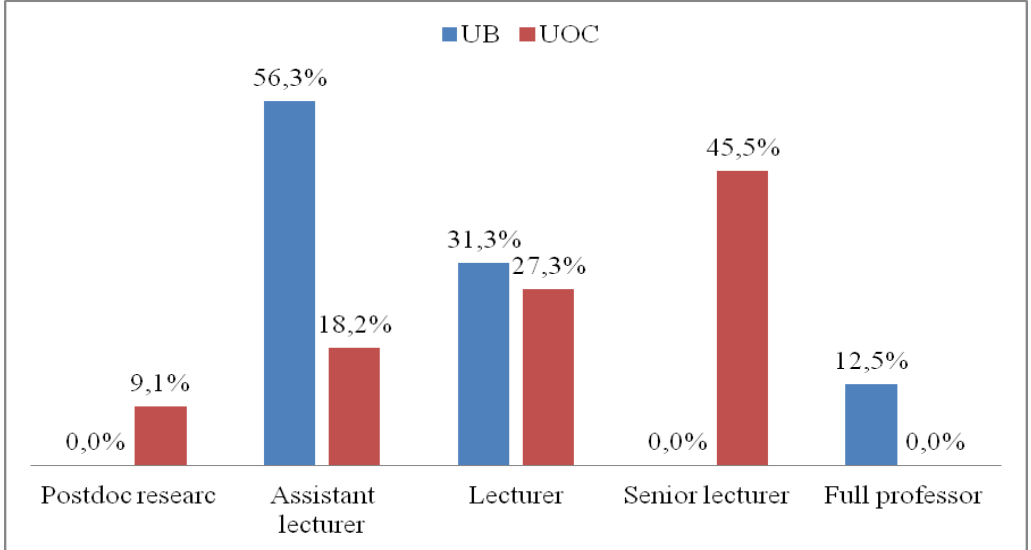
Figure 1. Comparison of the profile of the participants from the traditional university and the distance